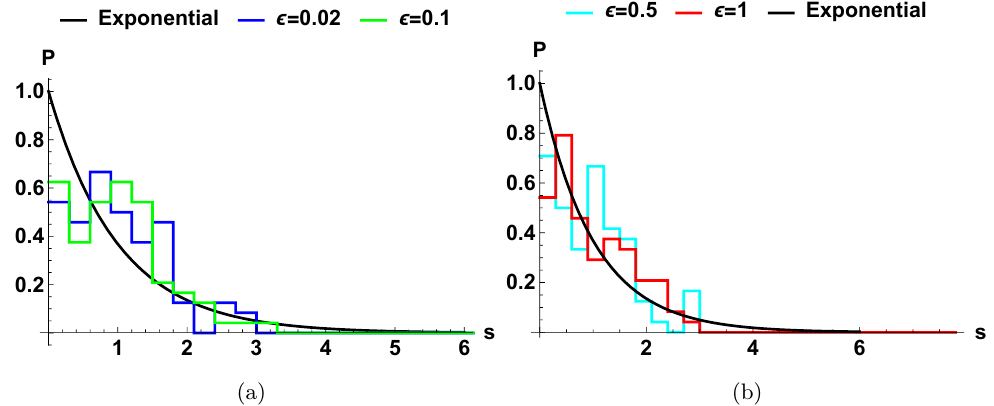
Figure 20 . Level spacing for free SYK with an integrable quartic perturbation (6.7) (a) when the coupling (cid:15) is small and (b) when the coupling is large. Both small and large coupling show integrable statistics.